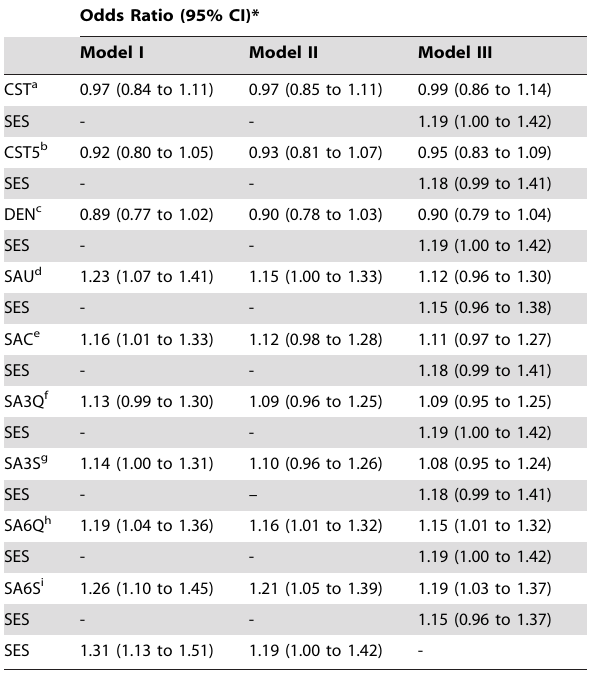
Table 6. Effects of block group spatial accessibility to mammography service and socioeconomic (SES) deprivation on risk of late-stage breast